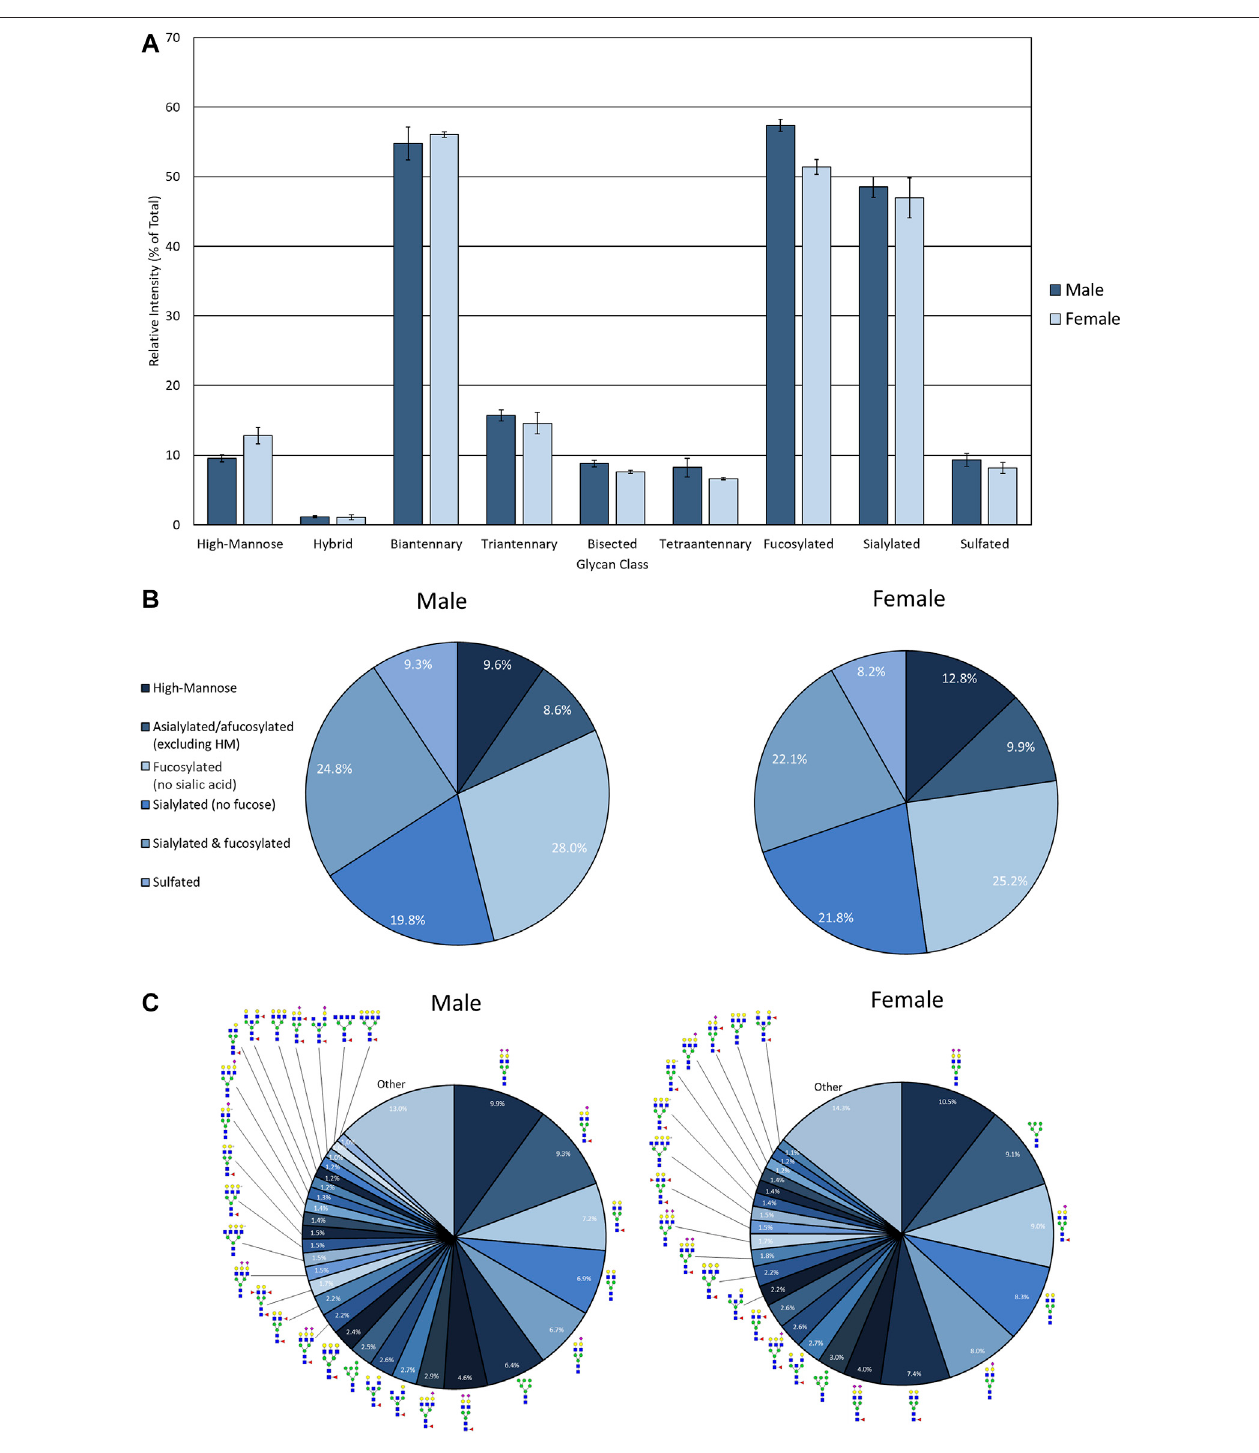
FIGURE4| N-glycanpro fi leofpooledhealthymaleandfemaleurineanalyzedmyMALDI-IMS. (A) Glycanclassabundancesofrepresentativesamplesdetermined bysummingtherelativeintensitiesoftheN-glycansassignedtothatclass.Samplewereanalyzedintechnicalquadruplicate.Errorbarsrepresentthestandarddeviation. (B) Distributions of representative samples ’ N-glycans assigned into groups based on composition. (C) Distribution of total glycan intensity by individual N-glycan, with N-glycans comprising at least 1% of the total intensity displayed and annotated. The N-glycan compositions are represented by blue squares for N -acetylglucosamine, green circles for mannose, yellow circles for galactose, purple diamonds for sialic acid, red triangles for fucose, and an “ S ” for sulfate.